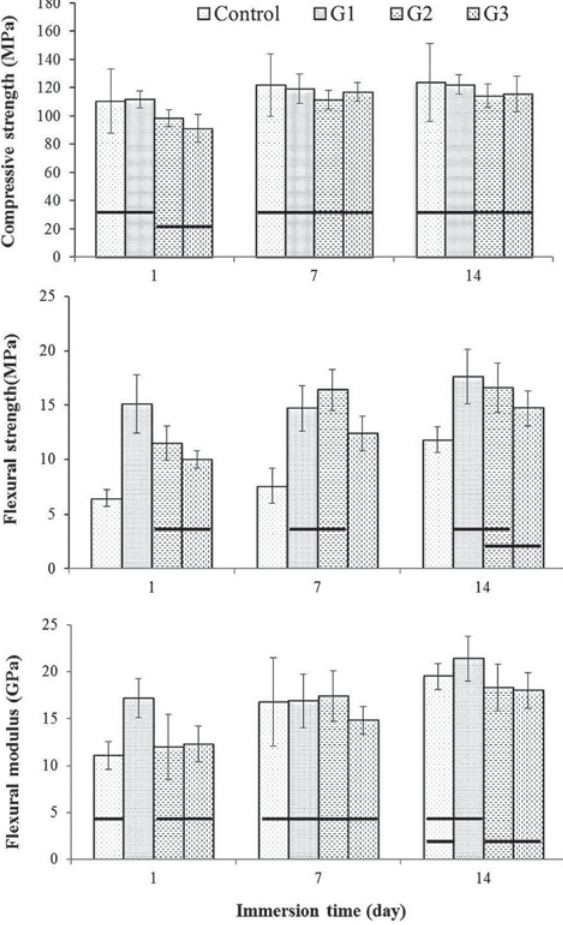
Figure 3- Mechanical properties of the glass ionomer cements as a function of immersion time. Horizontal